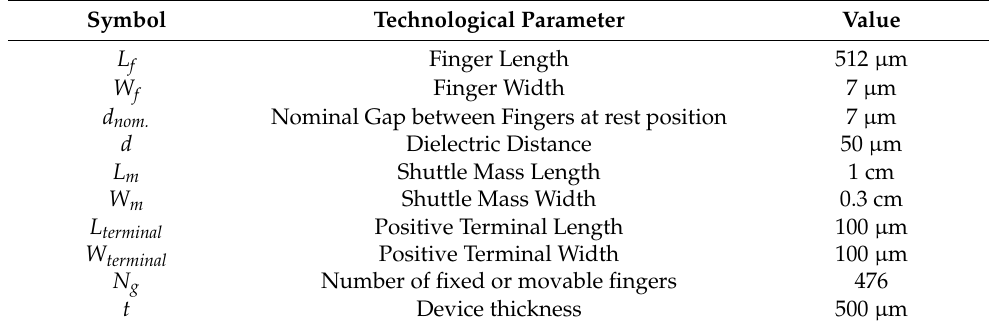
Table 1. Main technological parameters of the conventional gap-closing electrostatic MEMS converter comb drive for the case